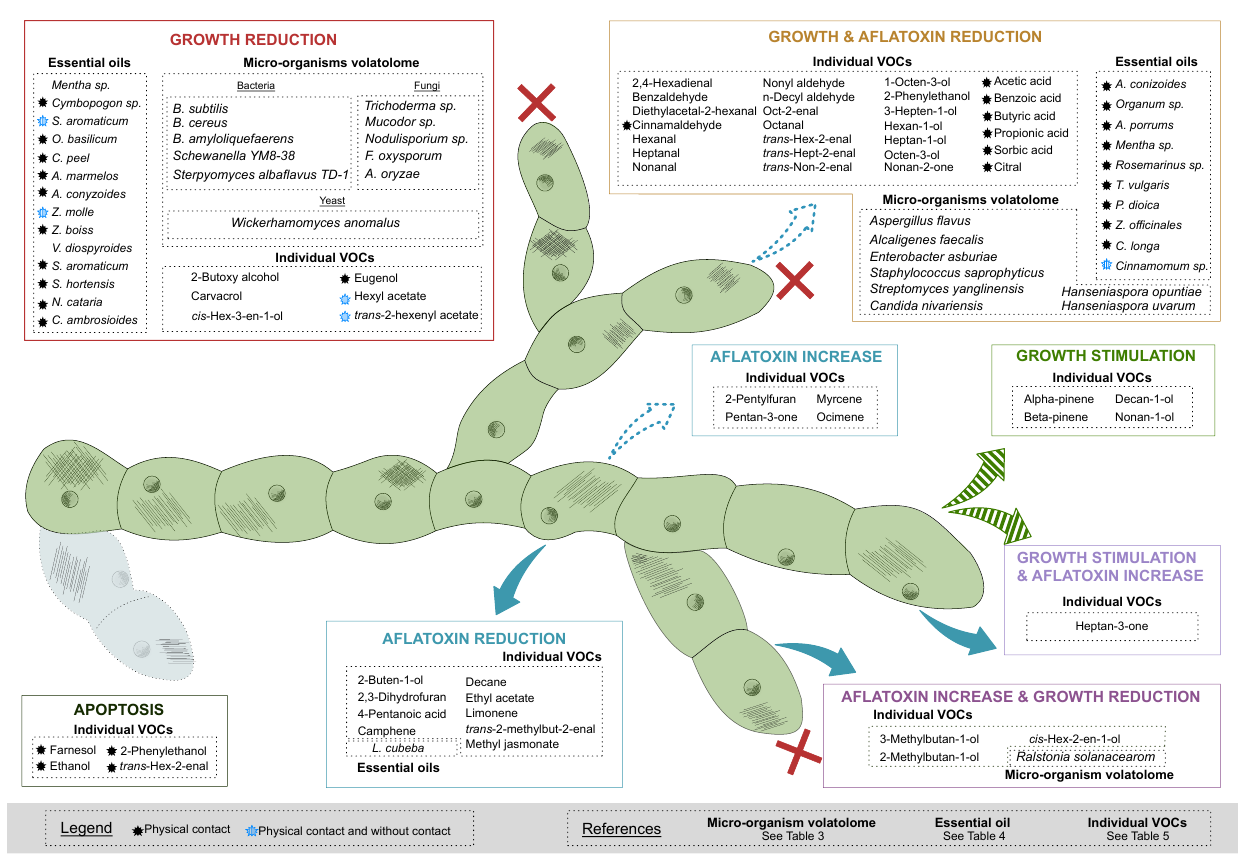
Figure 1. Summary of bioactive VOCs and species volatolomes influencing growth and AFB1 production parameters of A. flavus